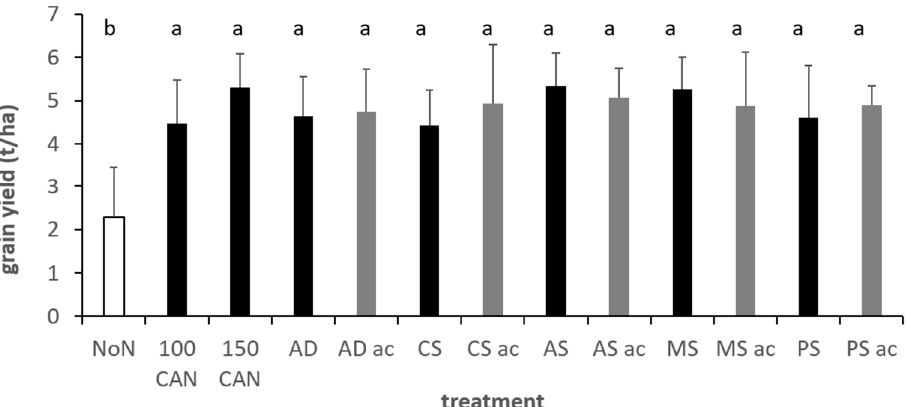
Figure 8. Grain yield in the different treatments across two winter wheat trials, Foulum, DK, grey colours indicate acidified variants. Fertilization level of applied slurries: 130 kg mineral N. Error bars depict standard deviations. Mixed effects model analysis with HSD post hoc test at p < 0.05. Lowercase letters indicate significant differences between treatments; ac, acidification; MS, mink slurry; PS, Pig; A, anaerobic digestate; AS, liquid phase separated A; CS, cattle slurry; 100/130, kg N ha − 1 applied as CAN .